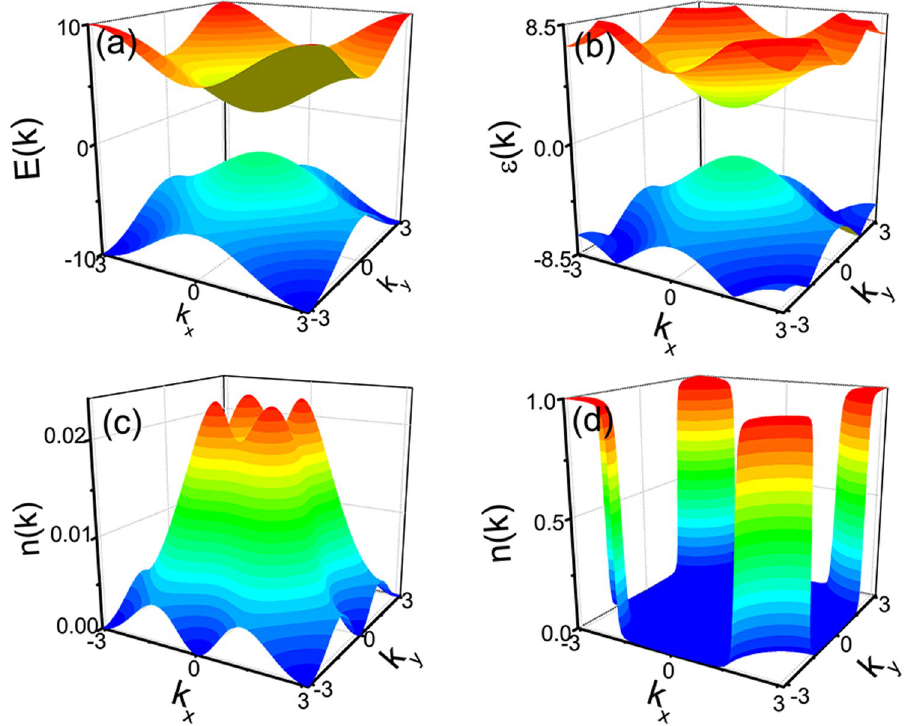
Figure 2. ( a ) And ( b ) are the dispersion of the two superfluid phases with the parameters as Fig. 1(a) and (b) respectively. ( c ) And ( d ) are the density distribution at the momentum space of the ( a ) and ( b ). The density of k = ( π , π ) point has a jump from 0 to 1 as decreasing ω . The jump is induced by a topological phase transition at ω = 2 E k = ( π , π )